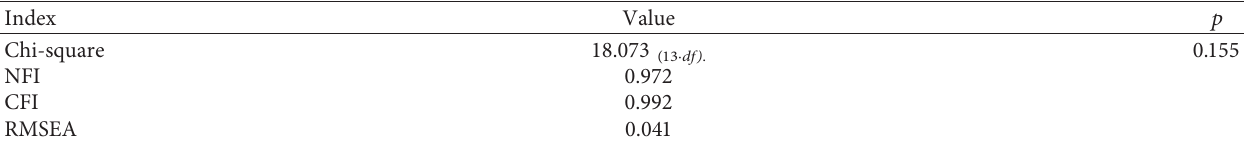
Table 3: Goodness-of-fit indices.